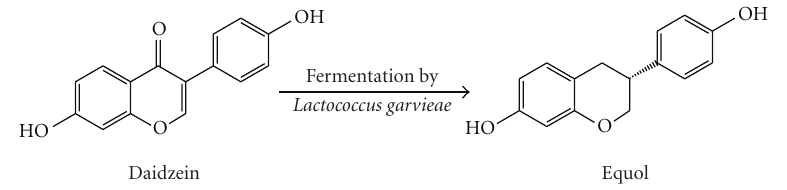
Figure 1: Daidzein metabolism to